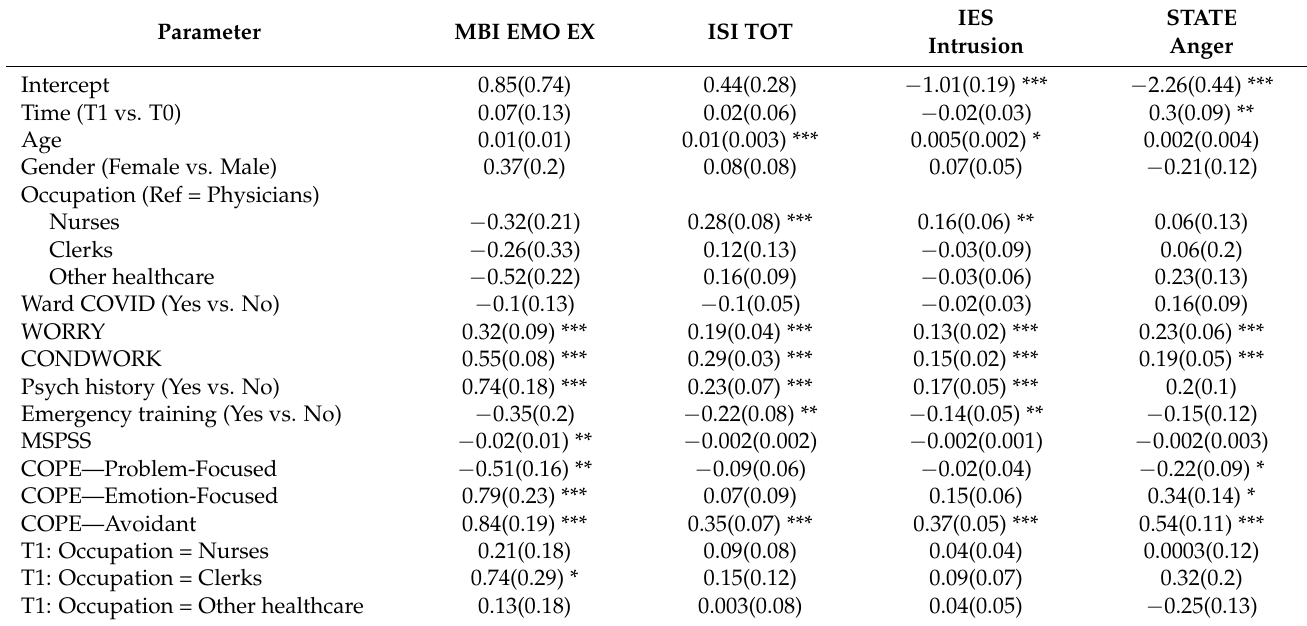
Table 4. Estimates (standard-errors) of the models for the MBI Emotional Exhaustion, ISI total score, IES-R Intrusion, and State Anger. Square root transformation was applied to the MBI Emotional Exhaustion scale, ISI total score, and IES-R Intrusion scale, while ordered quantile normalization was used for the State Anger